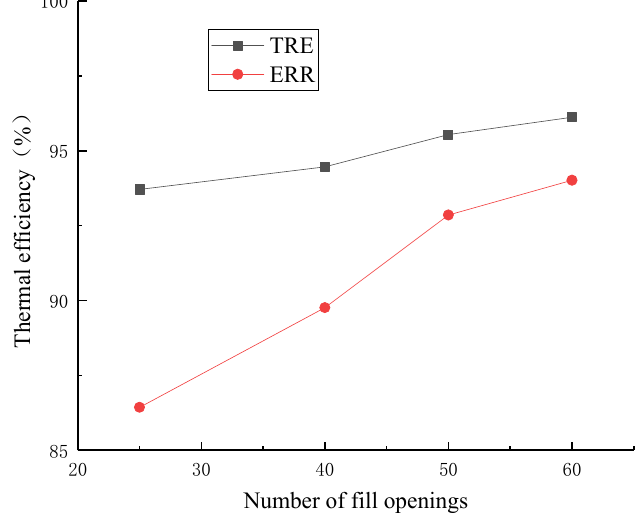
Figure 12. Effect of the numbers of regenerative media channels on heat transfer efficiencies.